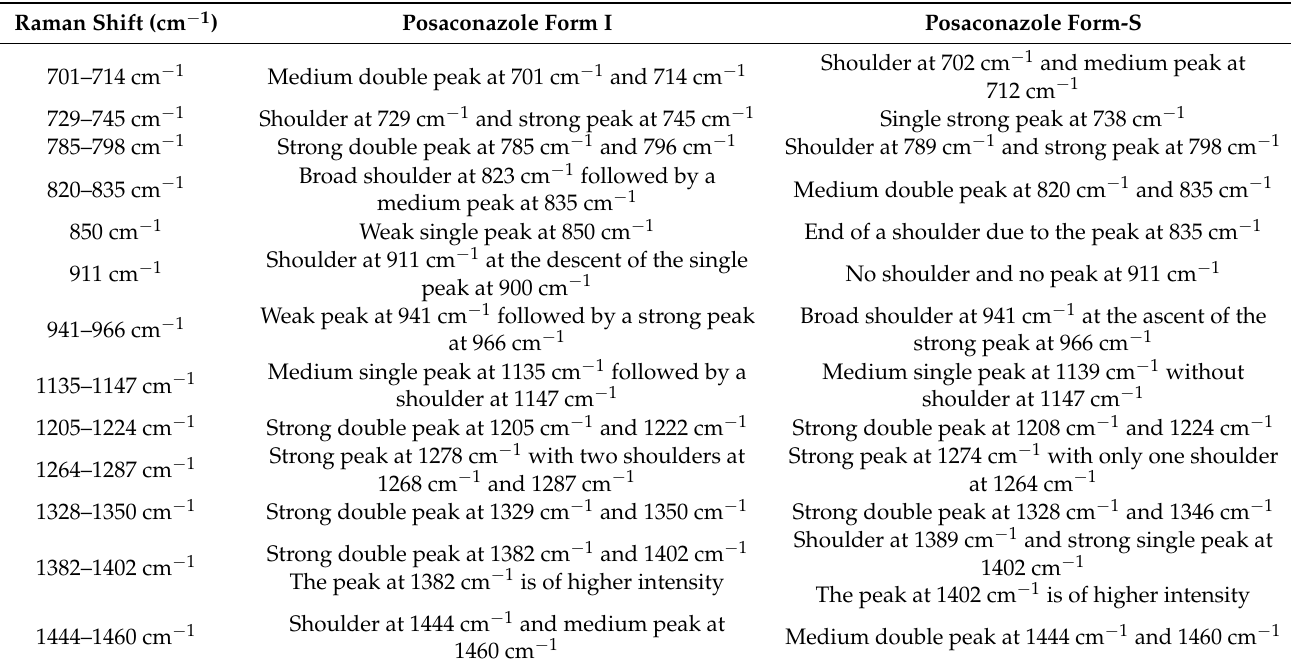
Table 4. Differences between the Raman spectra of posaconazole Form I and posaconazole